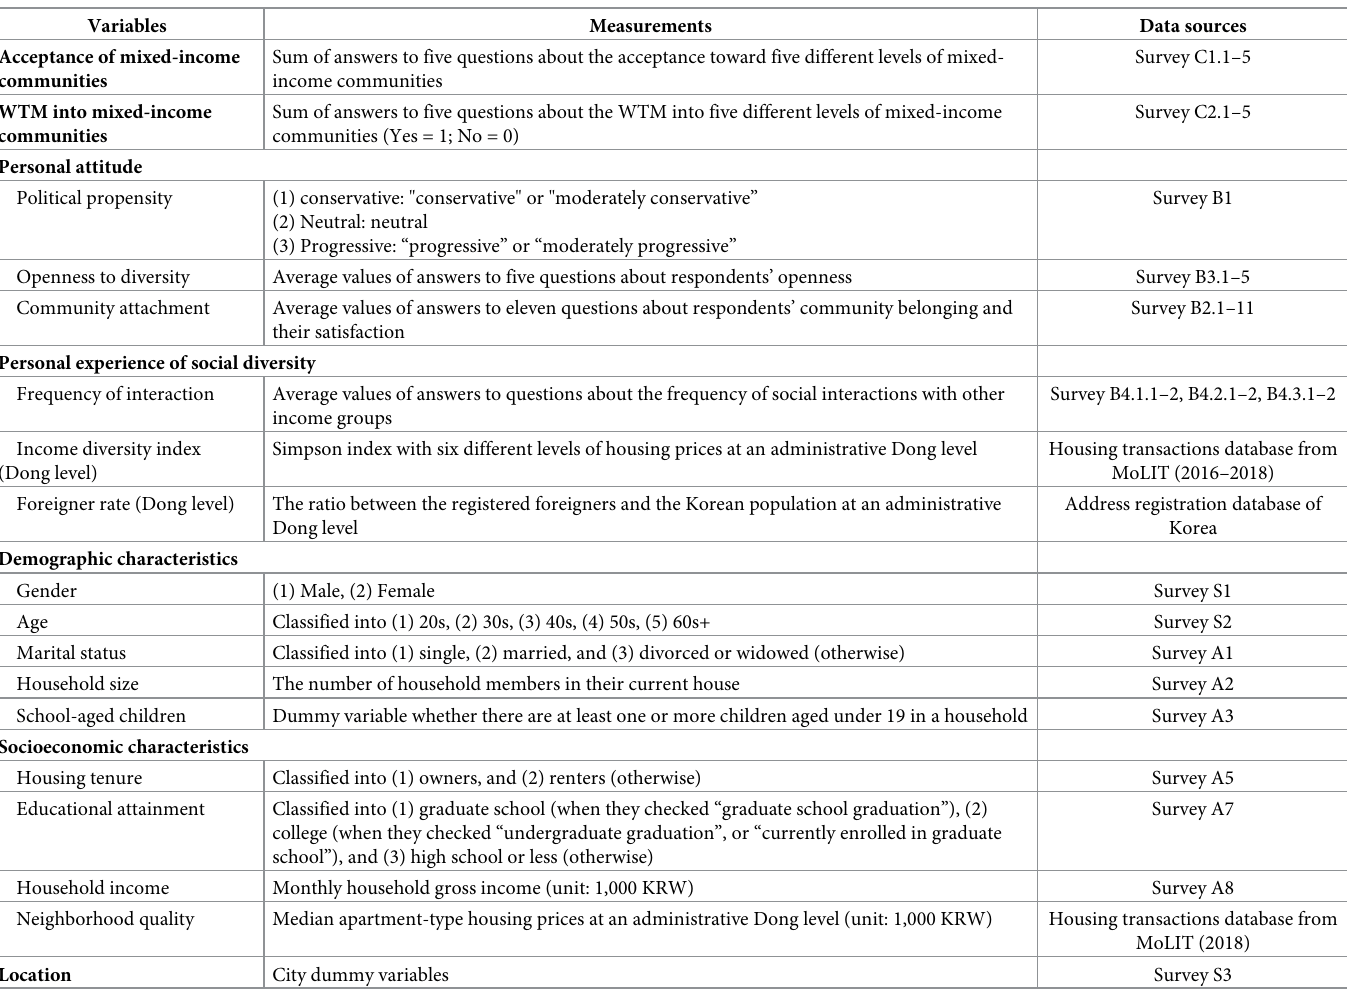
Table 1. Measurements and data sources of